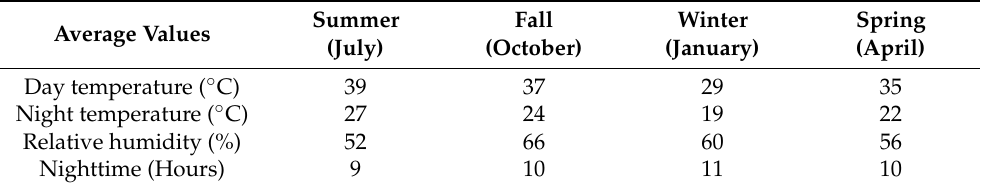
Table 3. Simulation scenarios (data source: [38]).